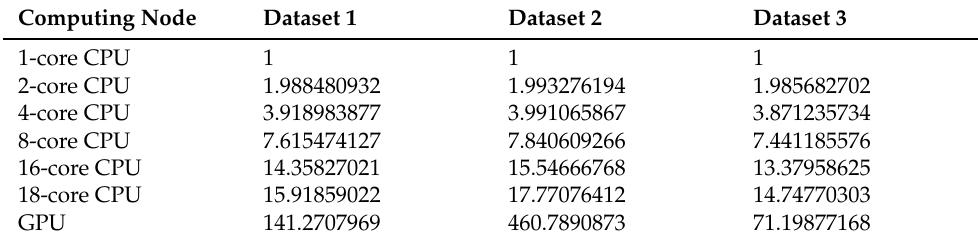
Table 2. Speedup of our proposed parallel multi-set GMM modeling